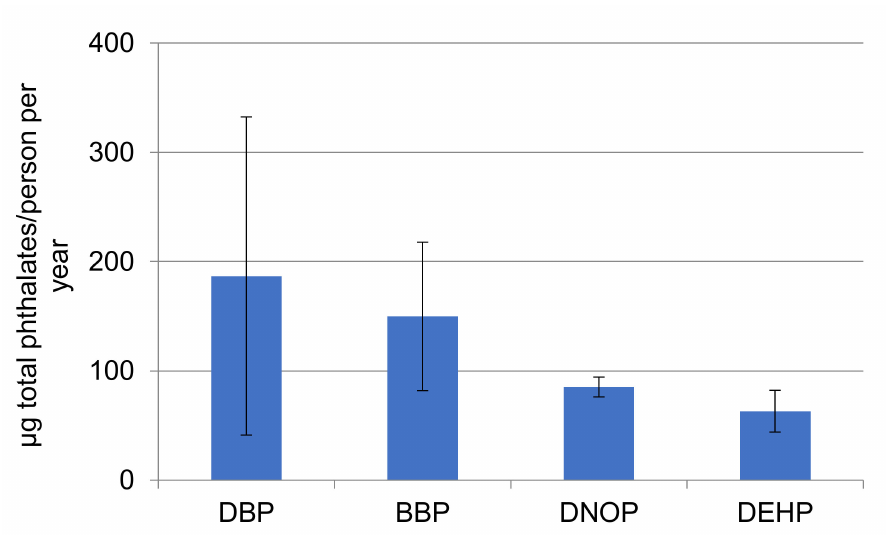
Figure 14. Mean phthalates ( n = 4) released per person/year considering that 10% of face masks reach the aquatic environment.